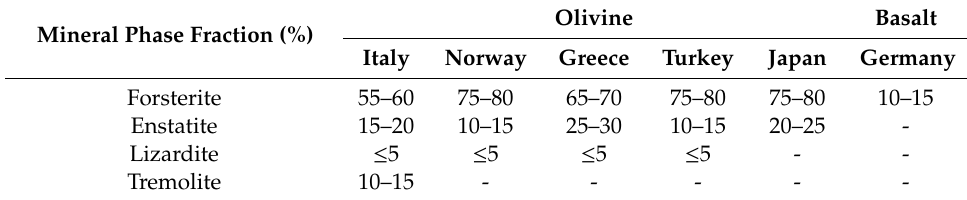
Table 2. Mineralogical composition by semi-quantitative examination of the present mineral phase fractions.